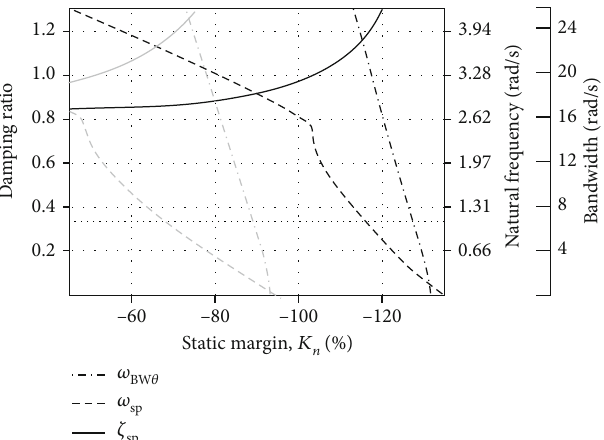
Figure 5: FQs of the closed-loop system with di ff erent controllers.